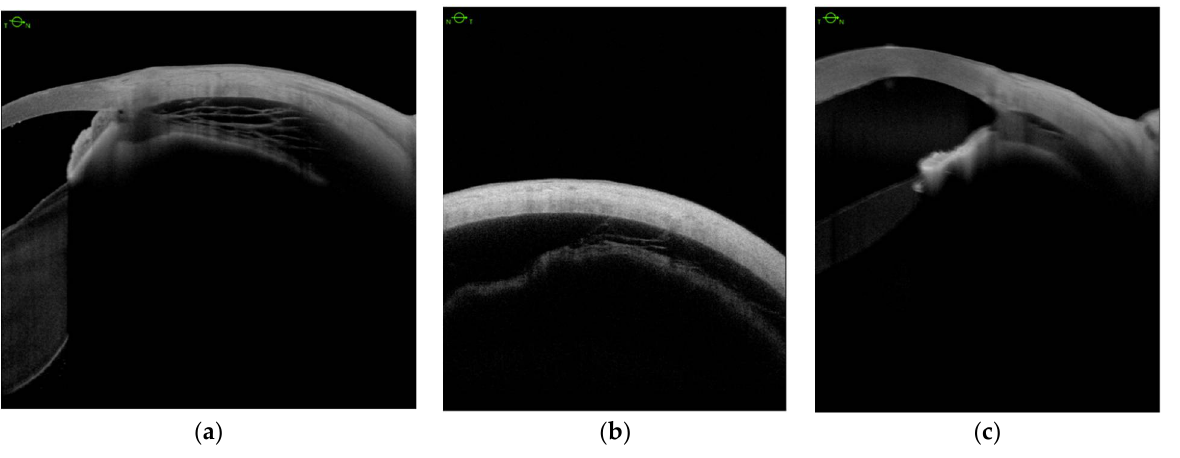
Figure 2. Anterior segment swept-source OCT. Ciliary body detachment between three types of fibers ( a ); supraciliary fluid in four quadrants in varying volume ( b ) and in the pars plicata ( c ).